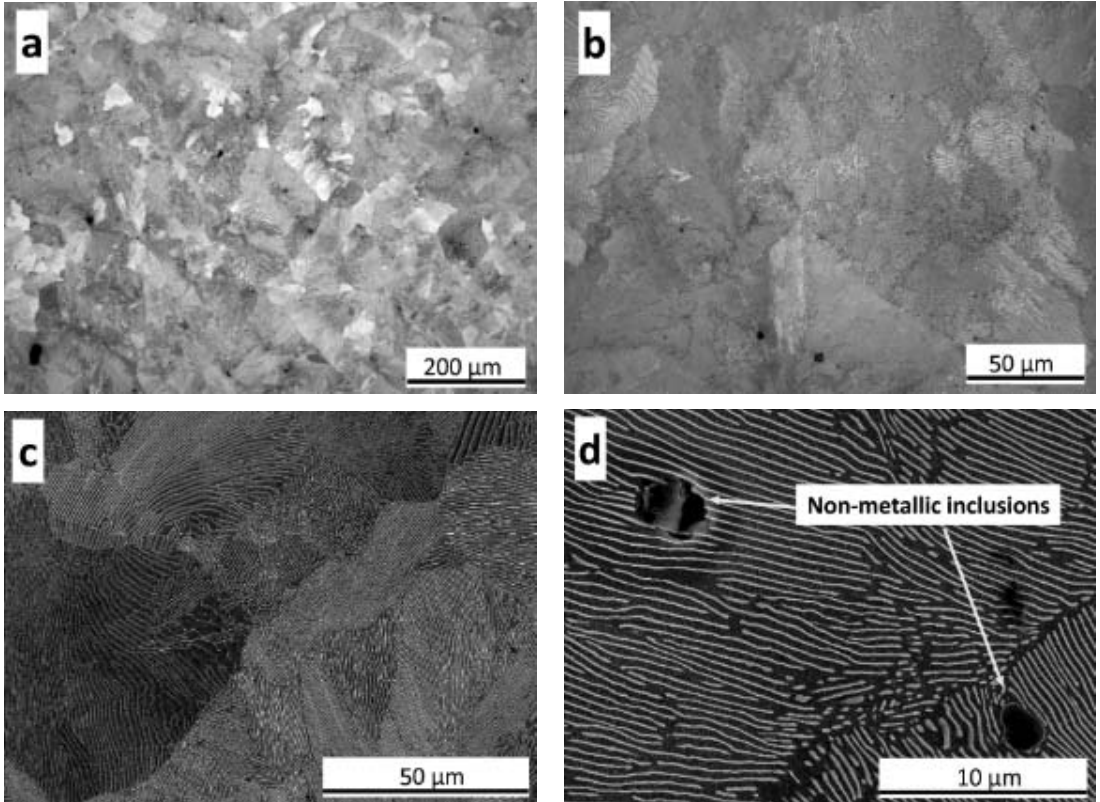
Figure 3. ( a,b ) LOM and ( c,d ) FEG ‐ SEM micrographs of the as ‐ cast microstructures obtained at different magnifications, showing a fully pearlitic structure. Black areas in ( d ), pinpointed by arrows are non ‐ metallic inclusions. Microstructure etched with Nital